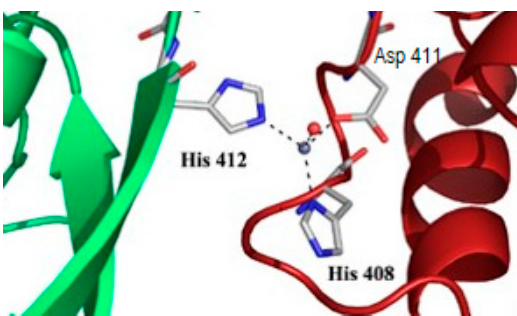
Figure 3. Interfacial zinc binding to Iron Regulatory Protein 1. Zinc was found associated with the protein in the C222 1 crystals [3]. The zinc ion interacts with one histidine (number 412) from one polypeptide (green), and one histidine (408) and one aspartate (411) from another polypeptide (red) in the crystal system. A water molecule completes tetrahedral coordination. RCSB databank entry: 2B3X.